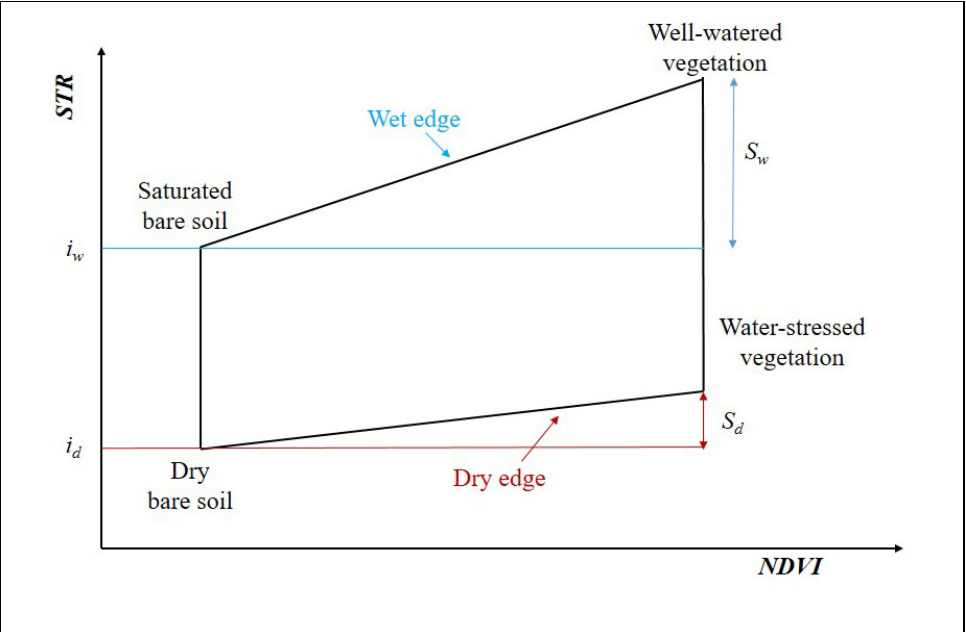
Figure 2. Sketch illustrating parameters of the optical trapezoidal model (OPTRAM) (Equation (5)). OPTRAM is parameterized based on the pixel distributions within the STR-NDVI space and was proposed by Sadeghi et al. [28]. Adapeted with permission from Ref. [28].